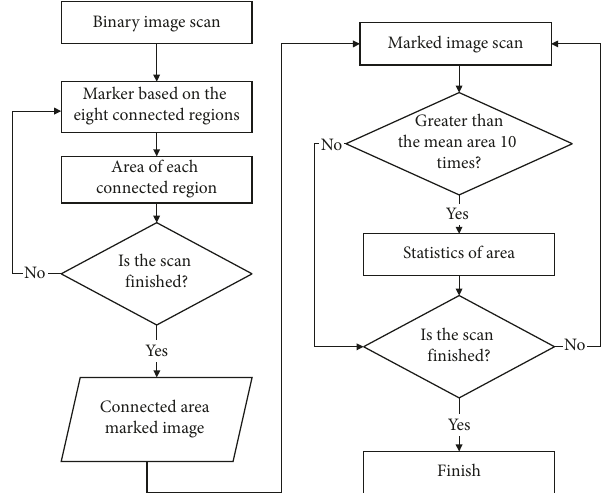
Figure 3: Flow chart of reflection elimination based on connected domain.